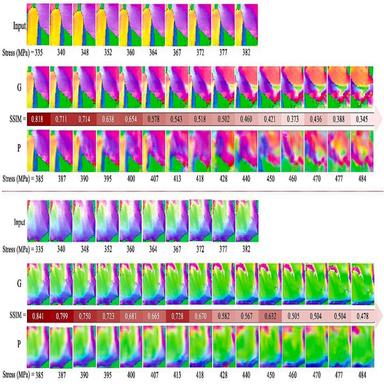
Examples of output frames predicted by the trained model based on the first 10 frames. G and P indicate ground truth and prediction. SSIM: structural similarity index measure.